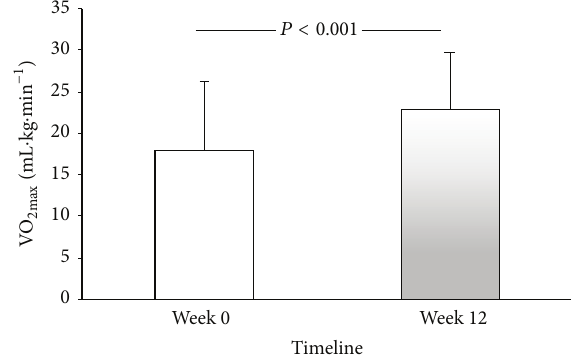
Figure 1: Influence of a medium-impact exercise program on car- diorespiratory fitness by submaximal VO 2 max